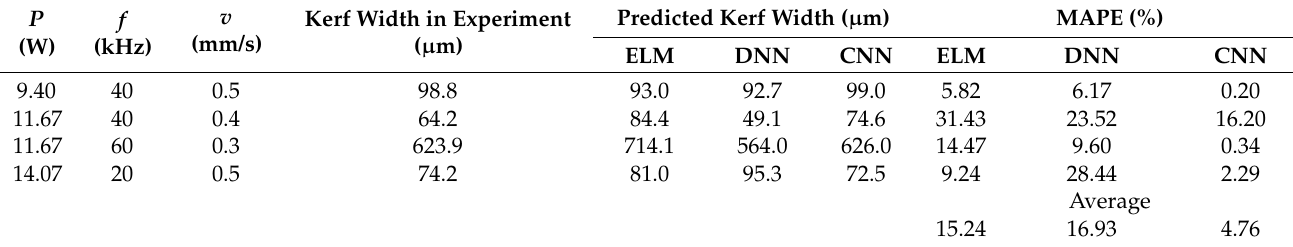
Figure 8. Variable importance analysis results using a random forest algorithm.